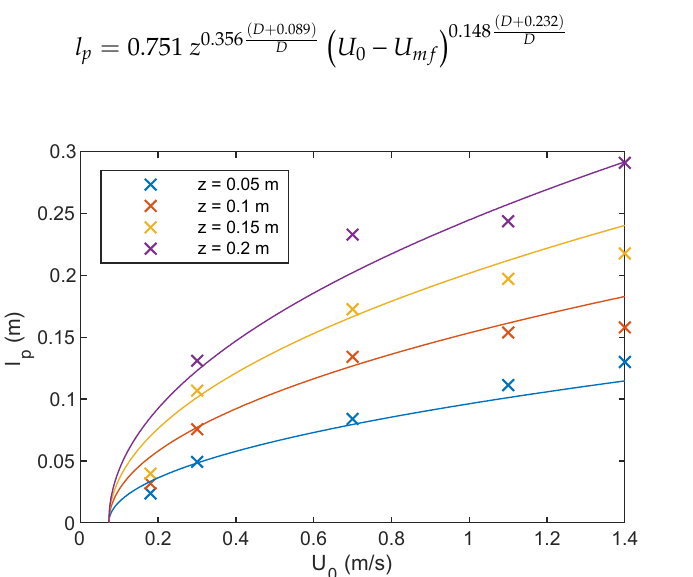
Figure 8. Cross-sectional averaged mean pierced lengths measured at different heights above the gas distributor compared with the correlation prediction as function of superficial gas velocity in the FB100 unit.